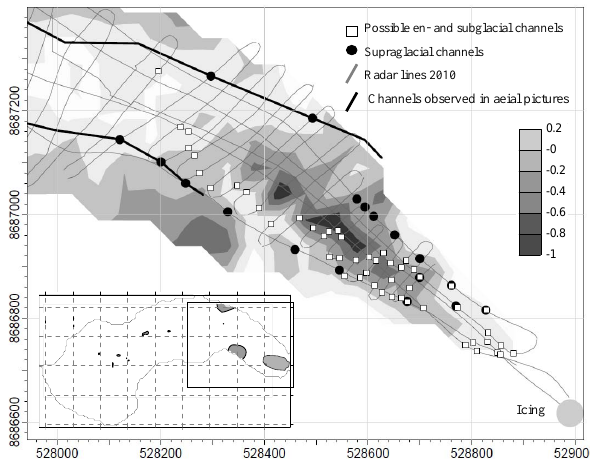
Fig. 3. Relative amplitude of the ice-bed reflector near the termi- nus of Tellbreen (2010). The dark grey areas have values below − 0.5, significantly lower than would be expected from a dry in- terface, and are most likely linked to the presence of water at the ice-rock/sediment interface. The insert of the whole glacier with map outline is from the 2009 survey but the areas with anomalies are